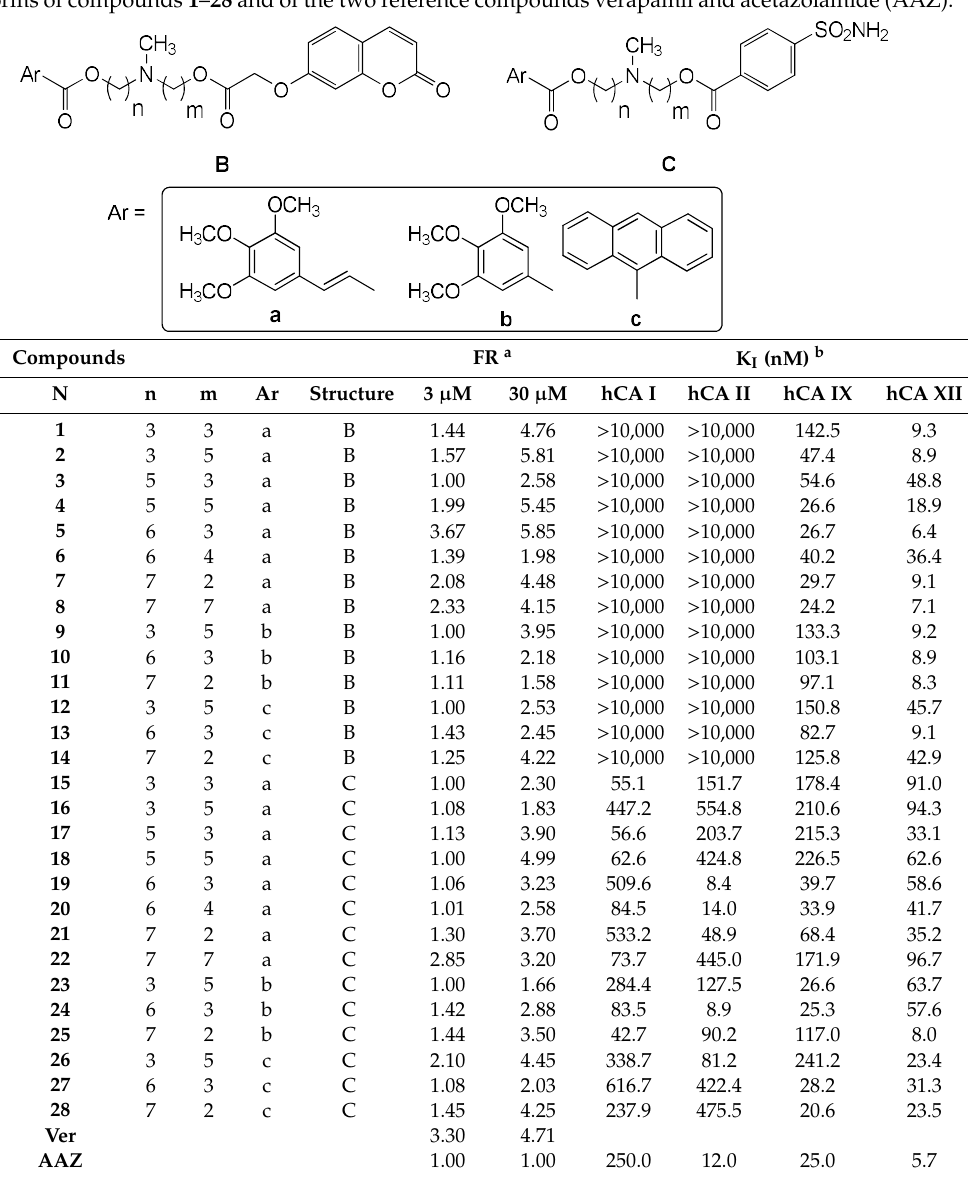
Table 1. Rhd 123 uptake enhancement on K562/DOX cells and inhibitory activity on hCA I, II, IX and XII isoforms of compounds 1 – 28 and of the two reference compounds verapamil and acetazolamide